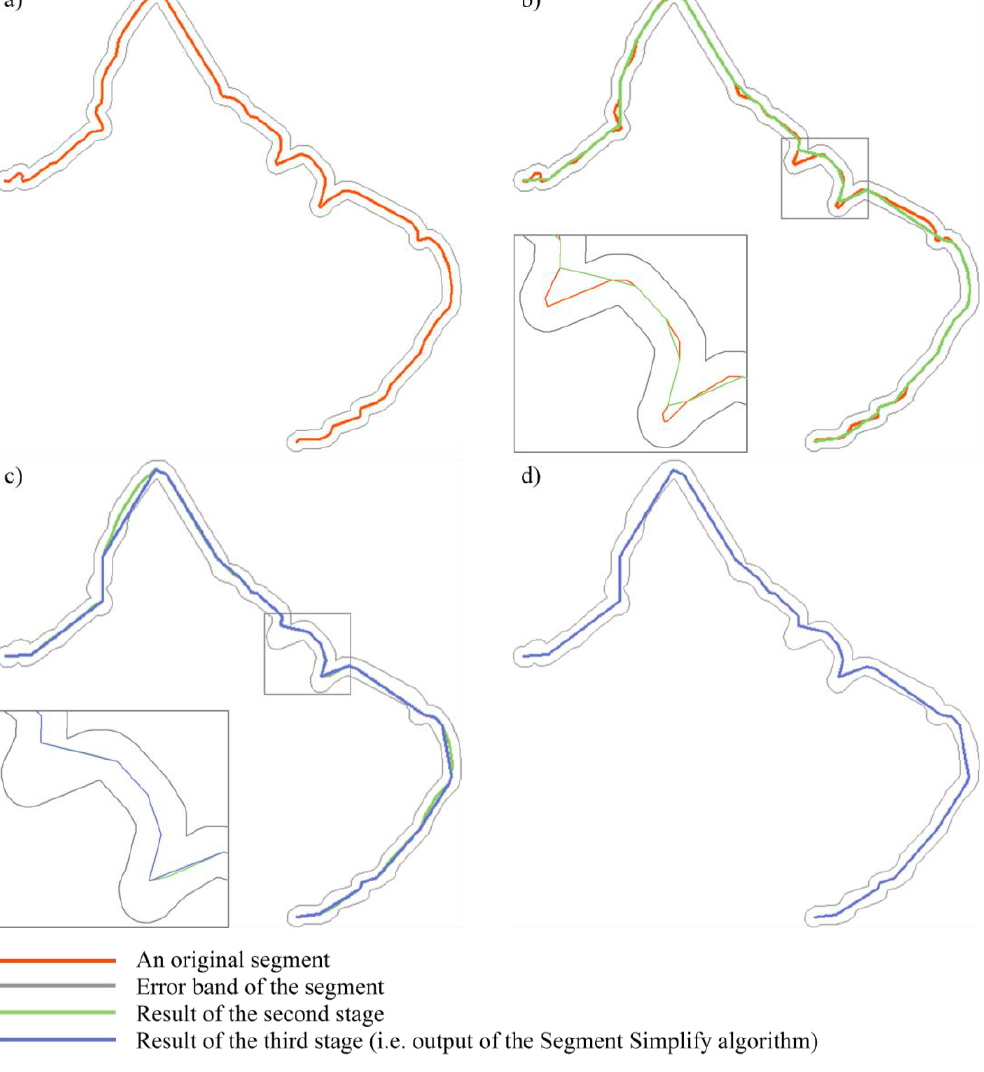
Figure 8. The stages of the Segment Simplify algorithm. ( a ) An original segment and its error band. ( b ) The result of the second stage. ( c ) The result of the third stage. ( d ) The output of the